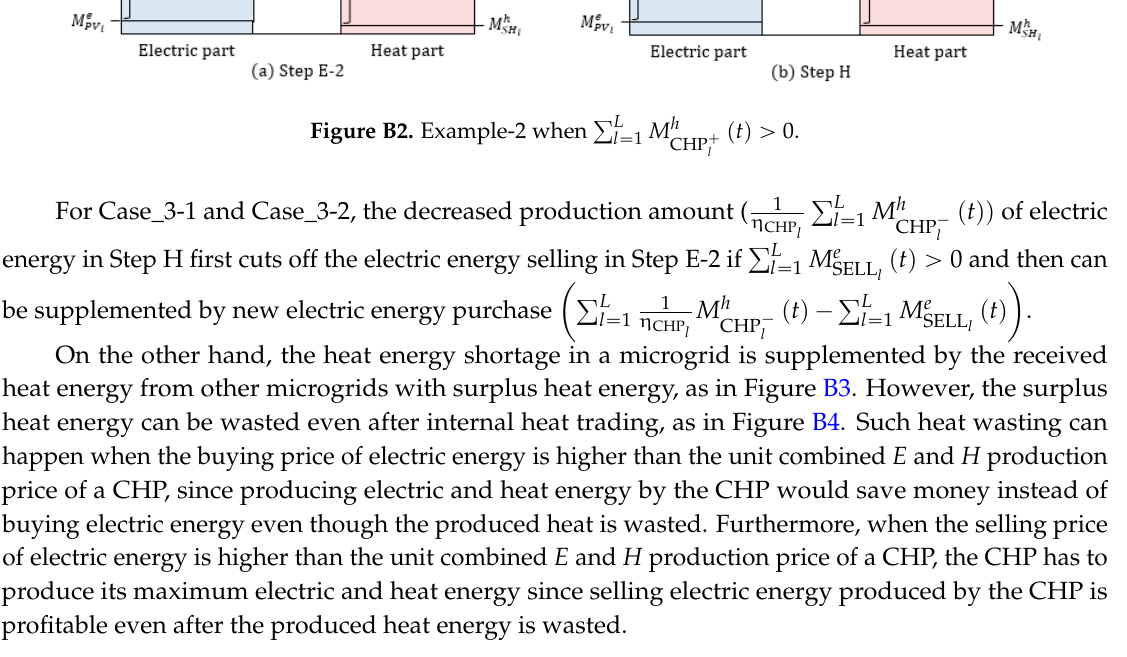
Figure B2. Example ‐ 2 when ∑